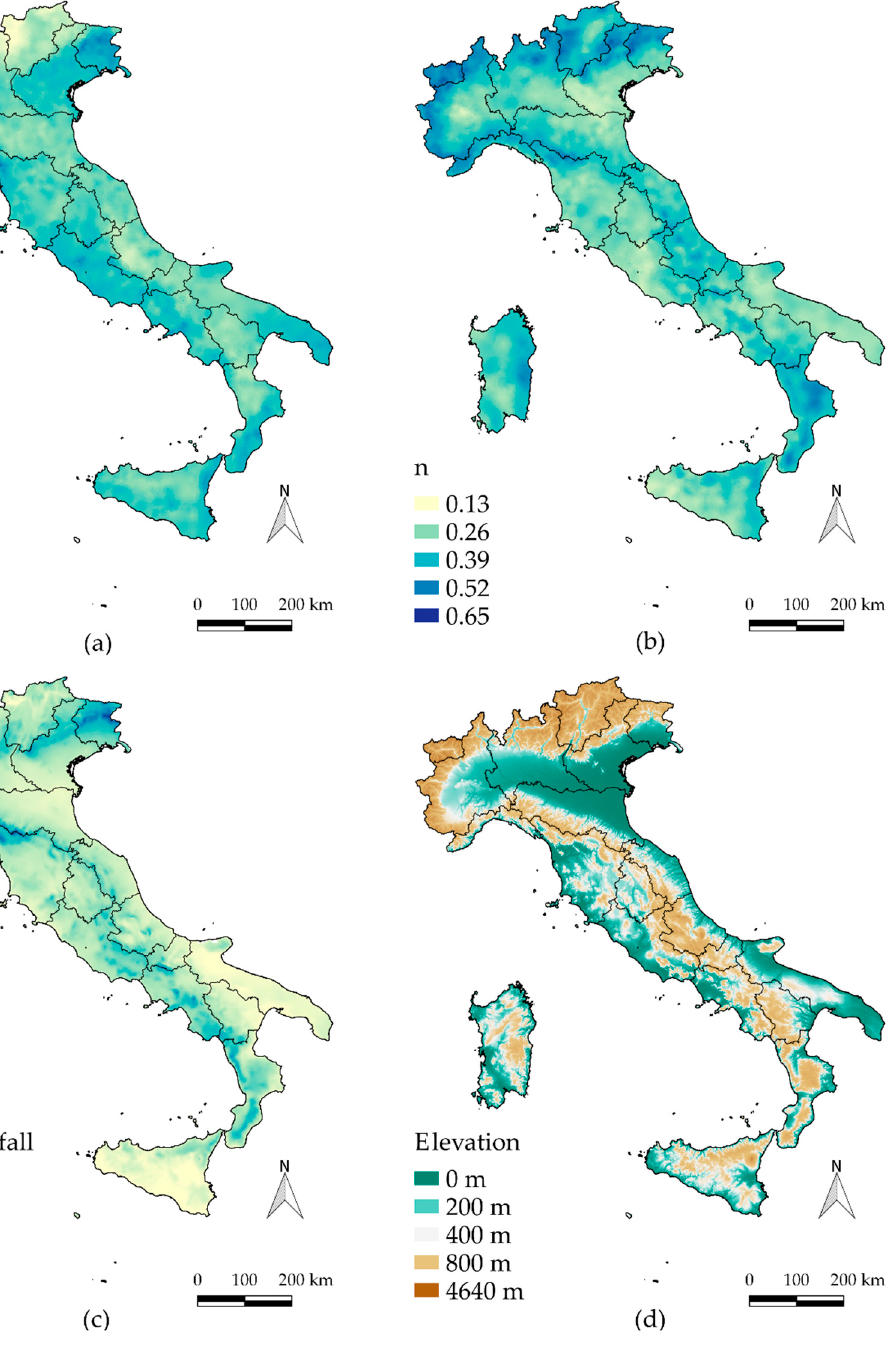
Figure 7. Parameters a ( a ) and n ( b ) of the DDF curves evaluated on the basis of the data contained in